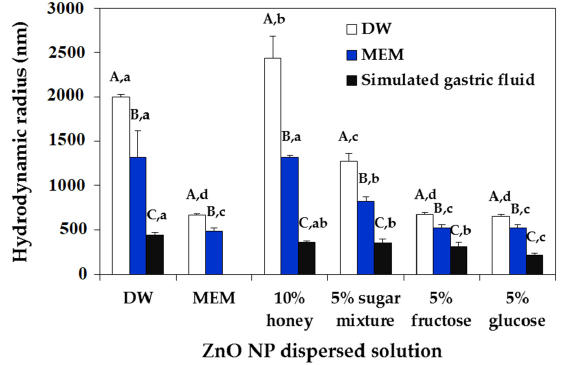
Figure 4. Hydrodynamic radii of ZnO NPs dispersed in DW, minimum essential medium (MEM), or different saccharide solutions for 1 h and then, measured in biological fluids (MEM and simulated gastric fluid) or DW as a control. Different capital letters (A–C) indicate significant differences between DLS measured biological fluids (DW, MEM and simulated gastric fluid) ( p < 0.05). Different lower-case letters (a–d) indicate significant differences between NP dispersed solutions (DW, MEM, 10% honey, 5% sugar mixture, 5% fructose and 5% glucose) ( p < 0.05). 5% sugar mixture consists of 5% fructose, 5% glucose, 5% sucrose and 5% maltose.